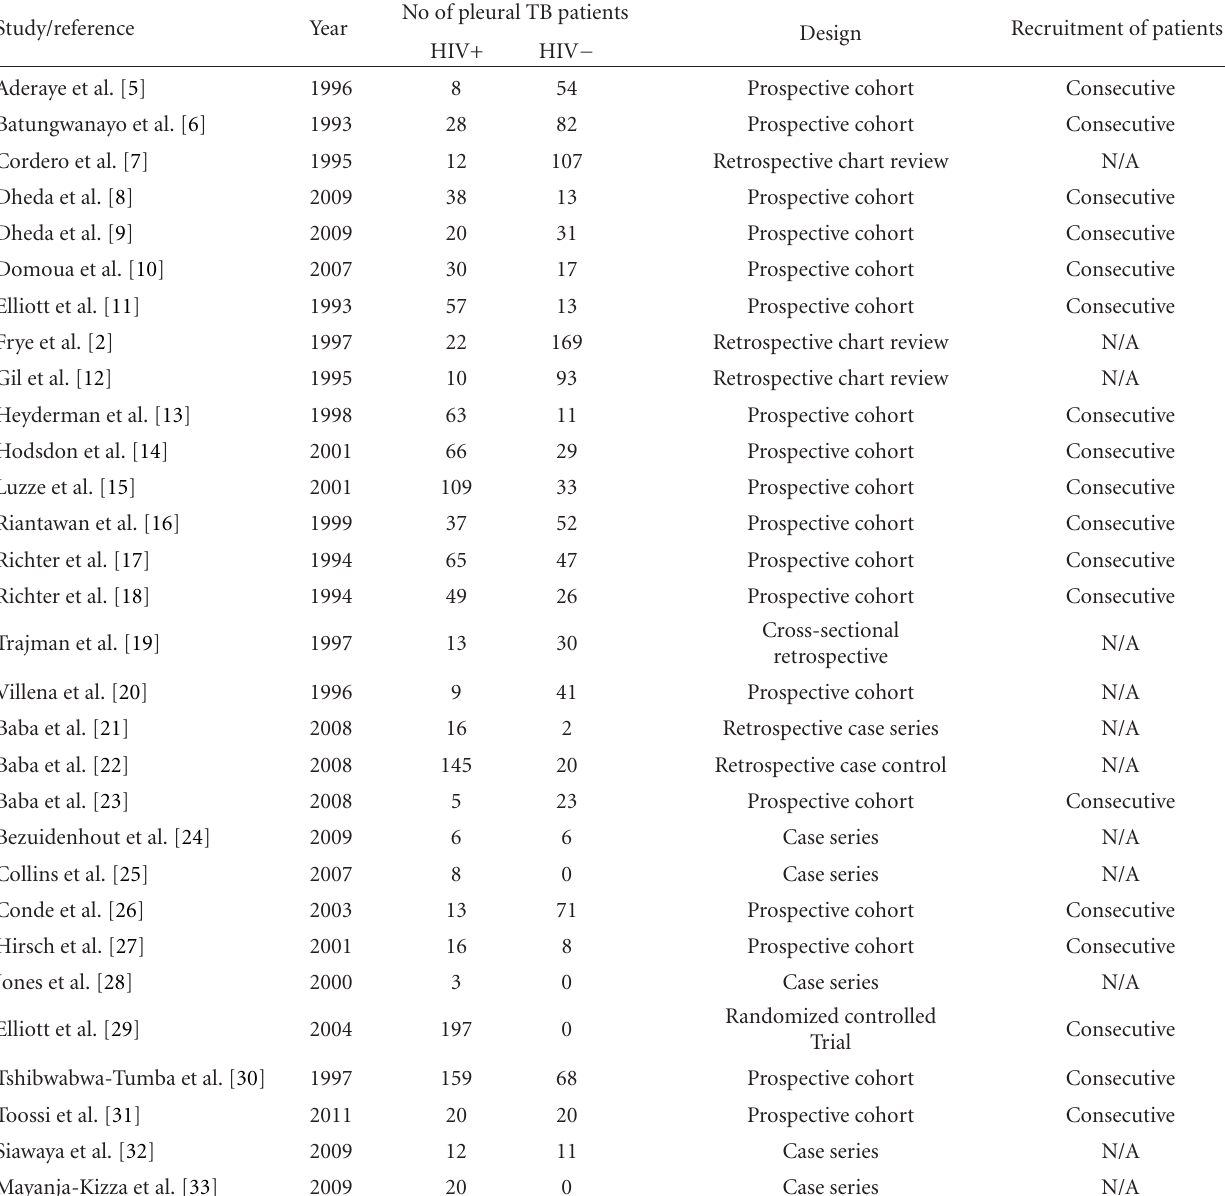
Table 1: Characteristics of included